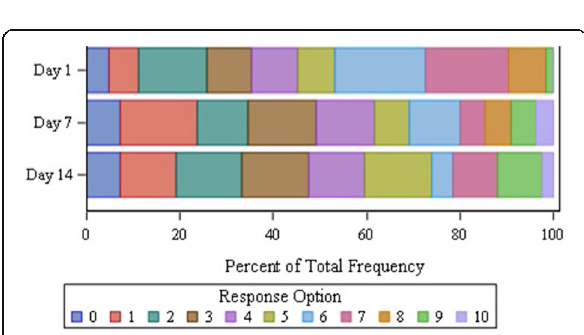
Fig. 2 Item Distribution for the Itch NRS and Floor-Ceiling Effects of the Response